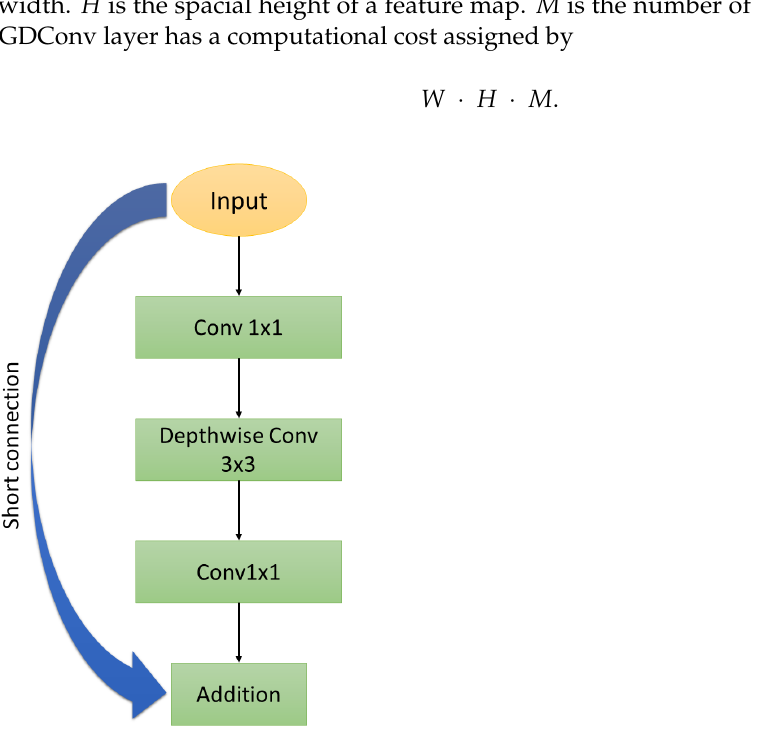
Figure 1. Bottleneck residual blocks in MobileFaceNet [41].